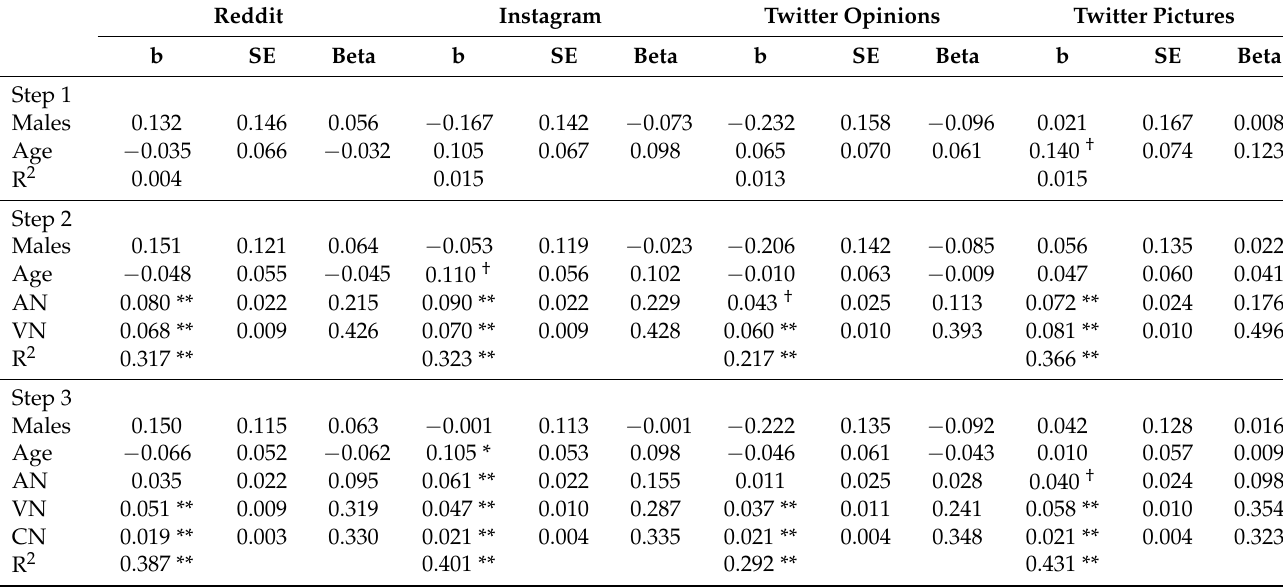
Table 4. Multiple linear regression predicting frequency of sharing of social media for Reddit, Instagram and Twitter, showing unstandardized coefficients (b), standard errors (SE) and standardized coefficients (Beta).